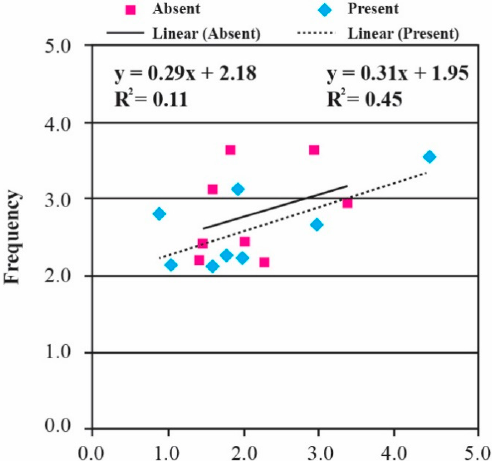
Figure 11. The frequency of SBS symptoms with or without plant placement.